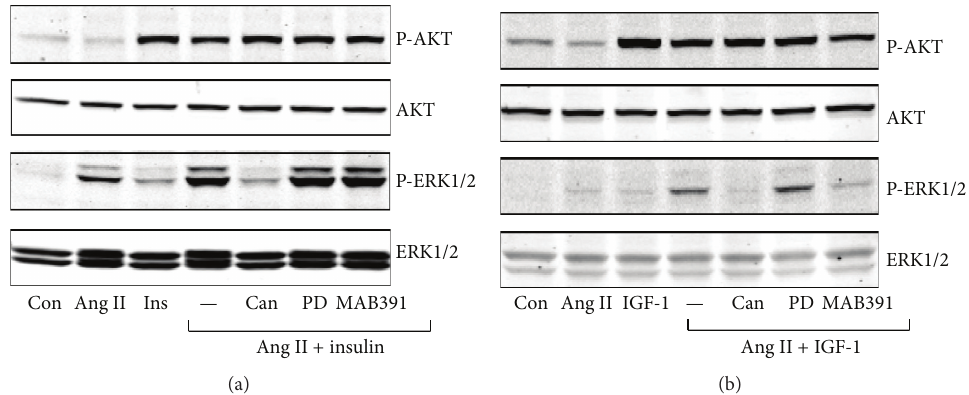
Figure 3: Effects of blockage of AT1R, AT2R, and IGF-1R on phosphorylation of ERK1/2 and AKT in H295R cells. H295R cells were treated with candesartan (1 𝜇 M), PD1233319 (1 𝜇 M), and MAB 391 (20 𝜇 g/mL) for 30 min, then incubated with Ang II (100nM) for 30 min, and then stimulated with insulin/IGF-1 for 5 min. (a) Insulin (100nM); (b) IGF-1 (10nM).